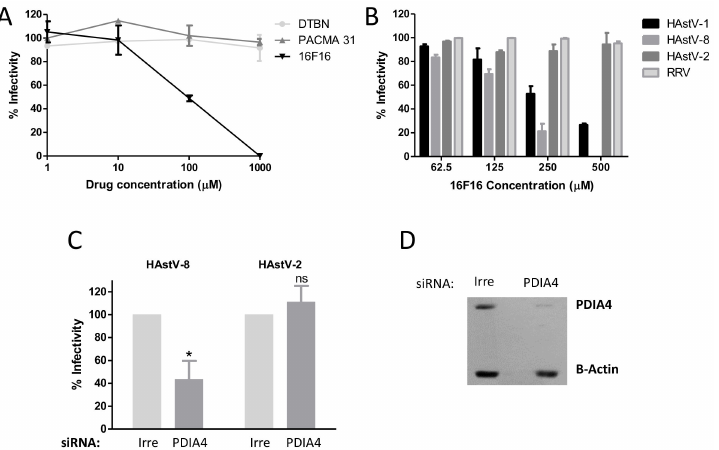
Figure 4. PDIA4 is important for astrovirus infection. ( A ) Caco-2 cells were incubated with the indicated PDI inhibitors for 1 h at 37 ◦ C, the cells were washed and infected with HAstV-8 and 16 h post-infection (hpi), and the viral infectivity was determined by an immunoperoxidase assay as described in Material and Methods. ( B ) Caco-2 cells were pre-treated for 1 h at 37 ◦ C with the indicated concentrations of PDI inhibitor 16F16. Cells were washed and infected with either HAstV-1, -2, -8 or with rhesus rotavirus (RRV), and the viral infectivity was determined. Data in A and B are expressed as percentage of viral infectivity compared to control cells treated with DMSO, which was taken as 100%. ( C ) Caco-2 cells were transfected with an siRNA pool directed to PDIA4 or with an irrelevant (Irre) siRNA pool, and 72 h post-transfection (hpt) cells were infected with the indicated HAstV strain (MOI = 0.025). At 16 hpi, the cells were fixed, and the viral infectivity was determined as described previously. Virus infectivity is expressed as the percentage of infected cells obtained in the control-transfected cells (Irre), which was taken as 100%. The arithmetic mean ± SEM from three independent experiments performed in duplicate is shown. * p < 0.05. ( D ) A representative Western blot showing the effect of the siRNA-PDIA4 on the expression of PDIA4 as compared to cells transfected with an irrelevant siRNA. β -Actin was used as a loading